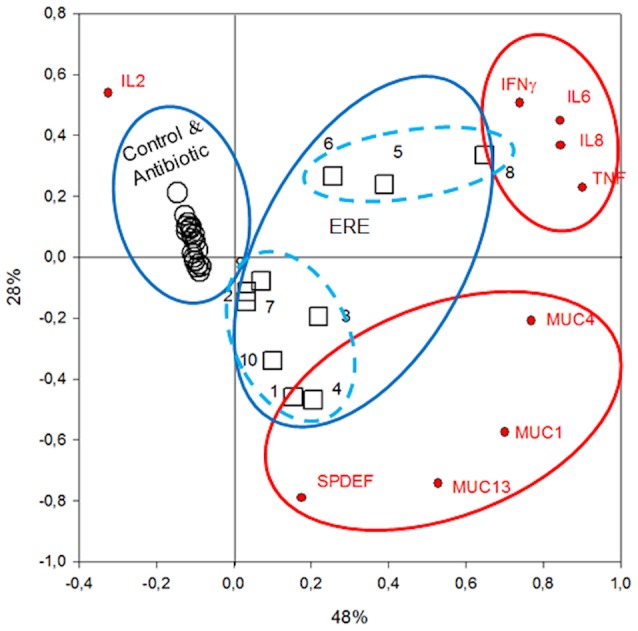
PCA of cytokine gene expression, where taxonomic data from each rabbit sample are projected.Red circles indicate groupings of gene expression data. Blue circles indicate the position of individual rabbits.